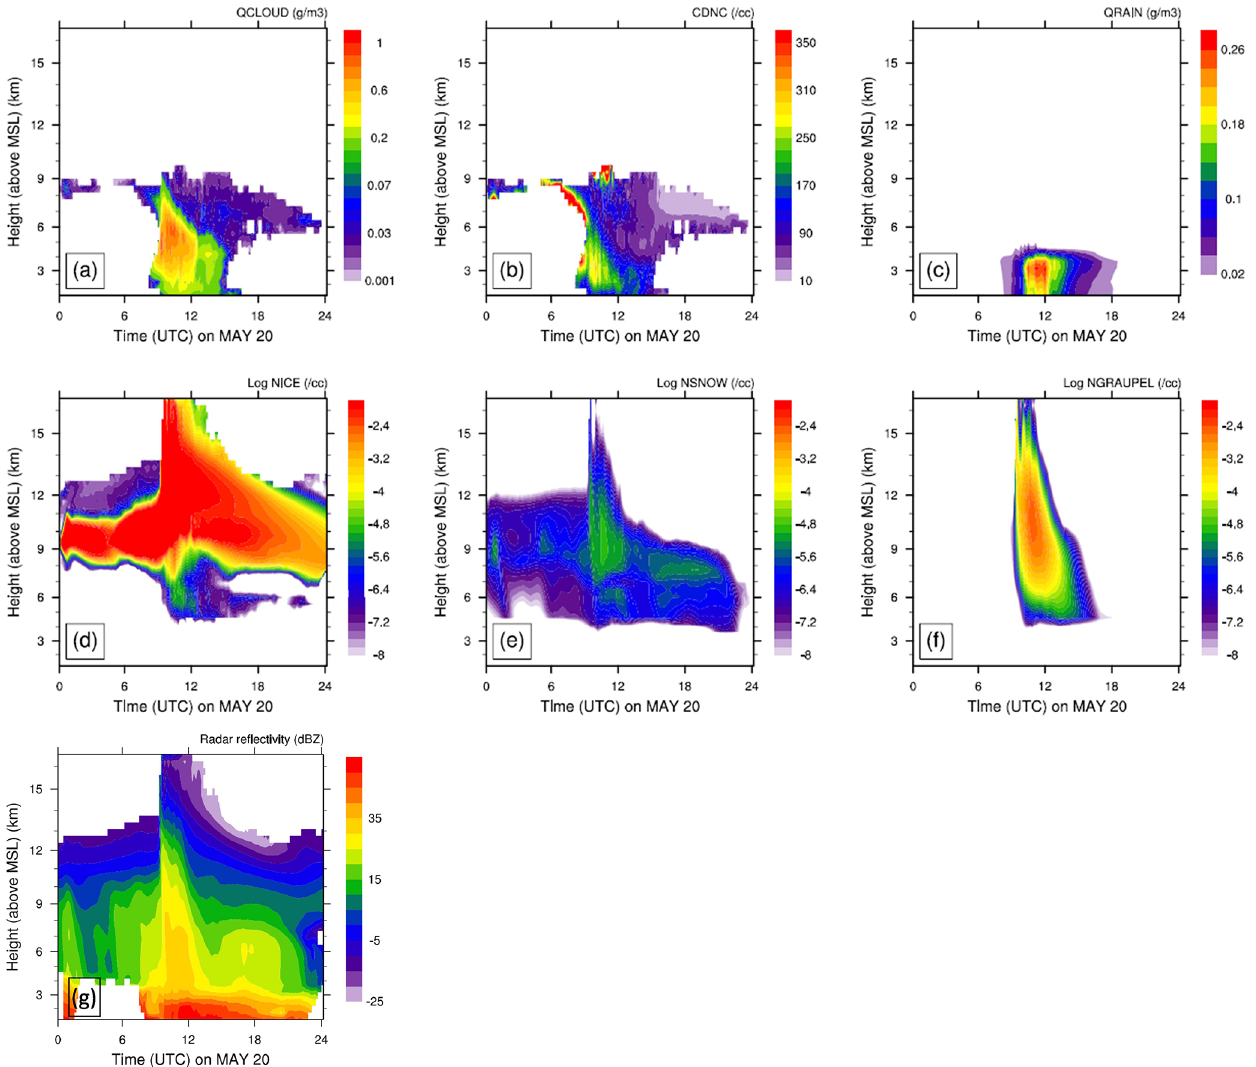
Figure 1. Time–height contours of the domain-averaged (a) cloud water mixing ratio (QCLOUD), (b) cloud droplet number concentration (CDNC), (c) rainwater mixing ratio (QRAIN), (d) number concentration of cloud ice (NICE), (e) number concentration of snow (NSNOW), and (f) number concentration of graupel (NGRAUPEL). Due to a wide range of values, the log values number concentrations are plotted. The surface height is ∼ 500m. The averaging was done for cloud points with LWC > 0 . 001gm − 3 or total water content (TWC) > 10 − 6 gm − 3 . Also shown is the time–height evolution of the domain-averaged (g) radar